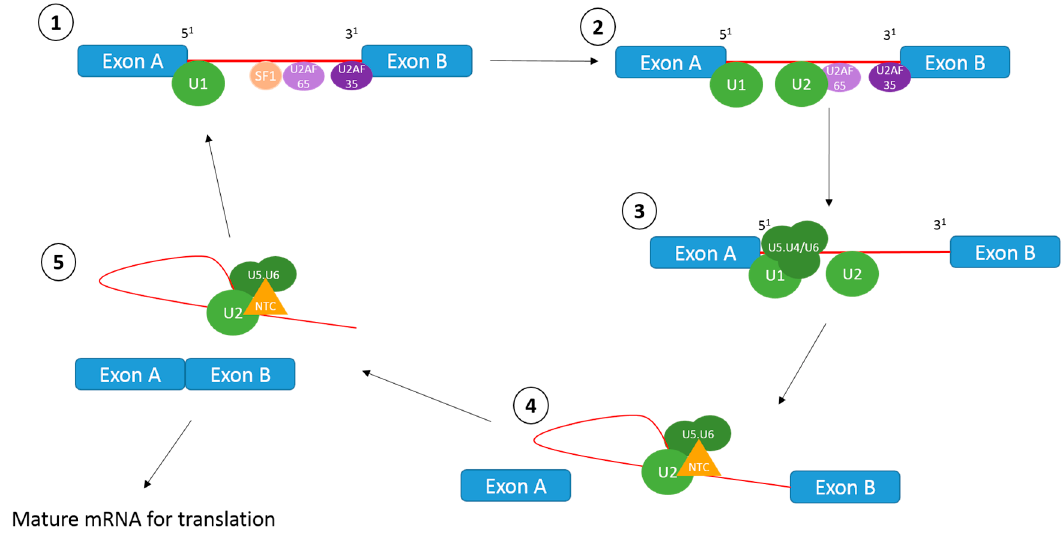
Figure 1. The splicing reaction. U1 snRNP binds to the CAG GURAGU consensus sequence, SF1 binds to the branch point sequence and U2AF35 binds to the 3 ′ splice site. The downstream polypyrimidine sequence of the branch point is bound by the U2AF65 subunit. SF1 is displaced by U2 and the U5. U4/U6 tri-snRNP is recruited to U1. Conformational and compositional rearrangements occur, which results in the release of U1 and U4, the addition of the NineTeen Complex (NTC), and the first transesterification reaction. A second transesterification reaction occurs which releases the lariat. Exons are ligated together and continue to translation. Introns are degraded and snRNPs are reprocessed for other splicing reactions.